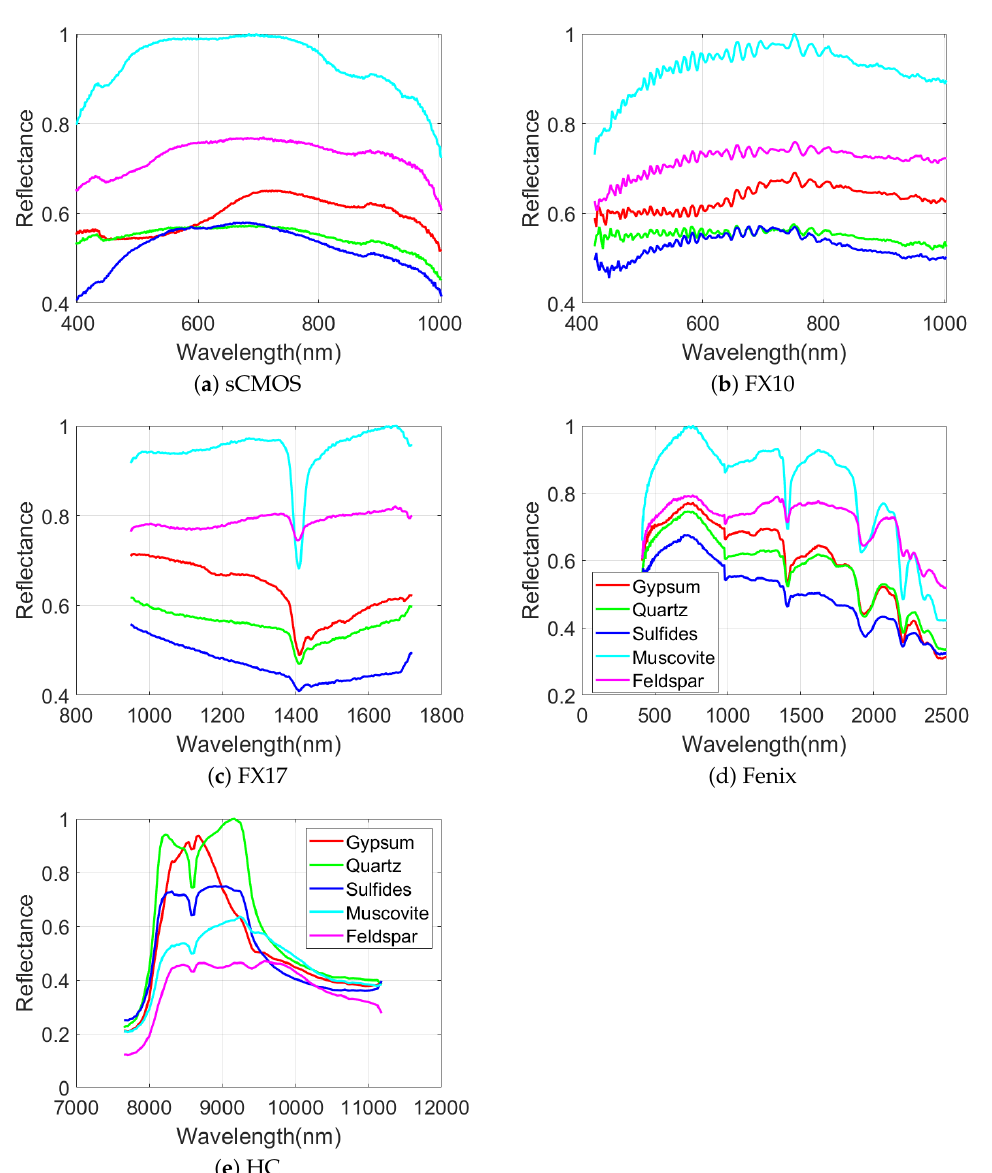
Figure 8. The spectral behaviors of different mineral classes of the TS4 dataset for different hyperspectral sensors. The results are based on spectral means over the minerals’ labels from the training